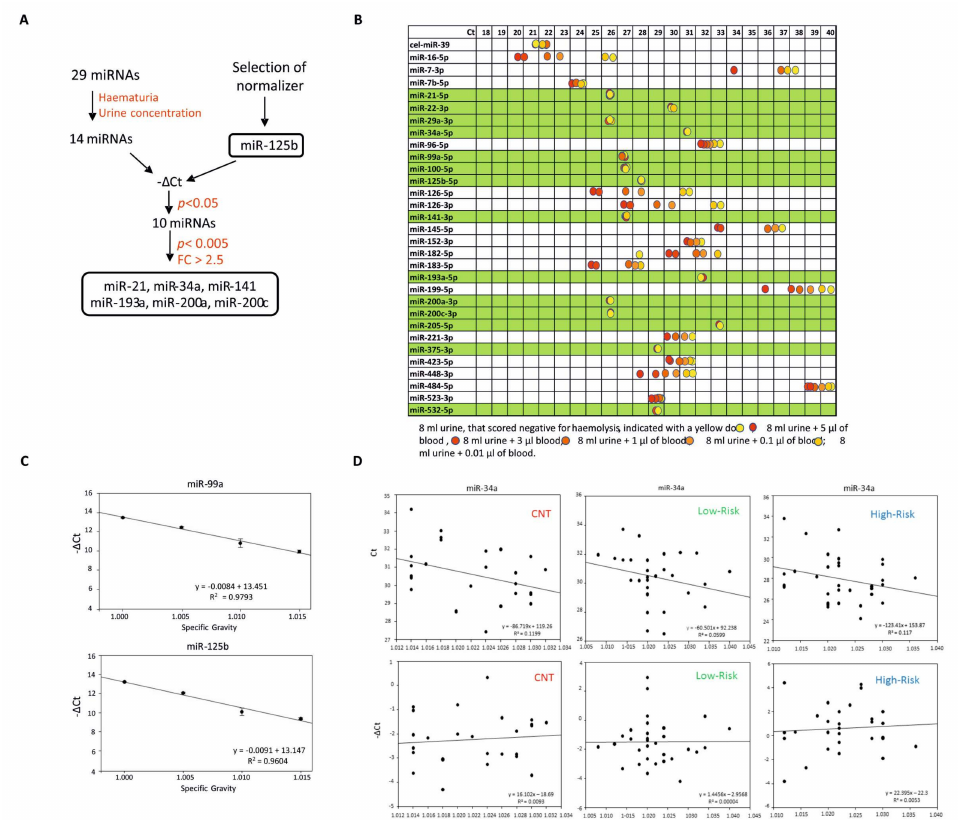
Figure 1. Study design. ( A ). miRNA selection pipeline. Starting from a total of 29 miRNAs, we assessed the common confounding factors haematuria and urine specific gravity (SG) to verify the robustness of miRNA quantification. Selective criteria were applied to reduce the number of miRNAs to be tested. ( B ). E ff ects of haematuria on urine miRNA levels. The indicated volumes of haemolyzed blood were added to a urine sample from a control volunteer, to construct a 6-point “curve”. miRNAs listed in the table were analyzed. Cel-miR-39 was added to the healthy control sample to verify the quality of the extraction. The levels of miRNAs highlighted in green were not influenced by the presence of blood. ( C ). Selection of normalizer. A control urine sample was diluted with water to obtain di ff erent SG. The graphs show the linear regression of − ∆ Ct ( ∆ Ct miR = Ct miR − Ct cel − miR − 39 ) of miR-99a and miR-125b vs. urine SG. The assay was performed in triplicate. Both normalizers correlated with urine SG, as indicated by their coe ffi cient of determination R 2 value (see plots). ( D ). Correlation with urine SG. The graphs report linear regression of miR-34a Ct or − ∆ Ct vs. urine samples’ SG in controls, low-risk and high-risk patients (values of coe ffi cient of determination R 2 are indicated). The graphs show that miR-34a levels did not correlate with SG when the miRNA was normalized for miR-125b ( − ∆ Ct) (bottom panels, see R 2